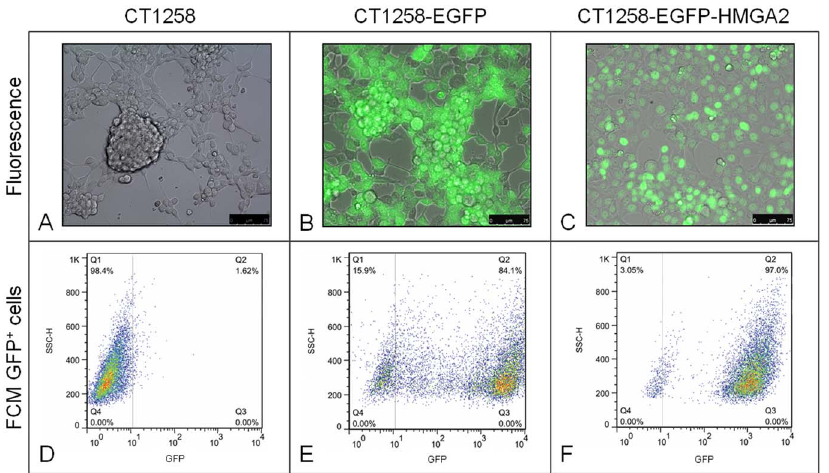
Figure 1. Fluorescence microscopy and flow cytometry analyses. A: Transmitted light image of the characteristic growth pattern of native CT1258 cells. B: Merged image of EGFP expressing CT1258-EGFP cells; EGFP is localised in the cytoplasm. C: Merged image of CT1258-EGFP-HMGA2 cells expressing the nuclear localised EGFP-HMGA2 fusion protein. D–F: Flow cytometric analyses of EGFP expression in the three CT1258 cell lines depicted in dot-plots showing side scatter (SSC) vs. EGFP fluorescence. No GFP fluorescence is detectable in native CT1258 cells (D), 84.1% of EGFP- positive cells are present in the CT1258-EGFP cell line and (F) 97.0% EGFP-positive cells in CT1258-EGFP-HMGA2. Per sample 1 6 10 4 events were analysed.